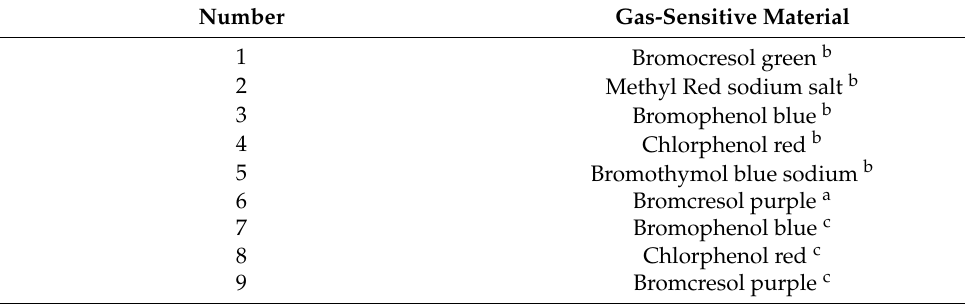
Table 2. Nine kinds of gas-sensitive materials. Number Gas-Sensitive